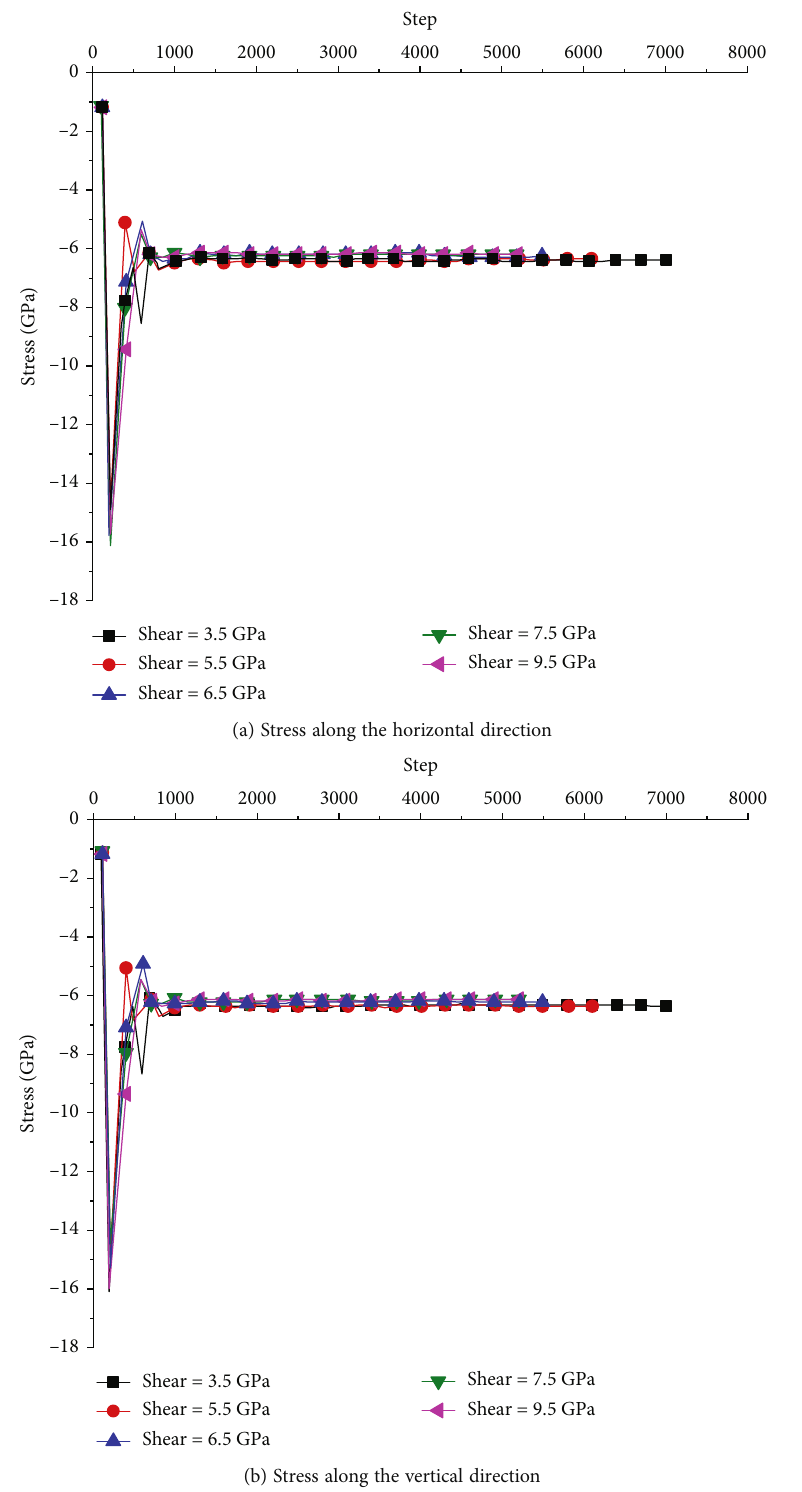
Figure 13: Variation of the stress when the shear modulus is di ff